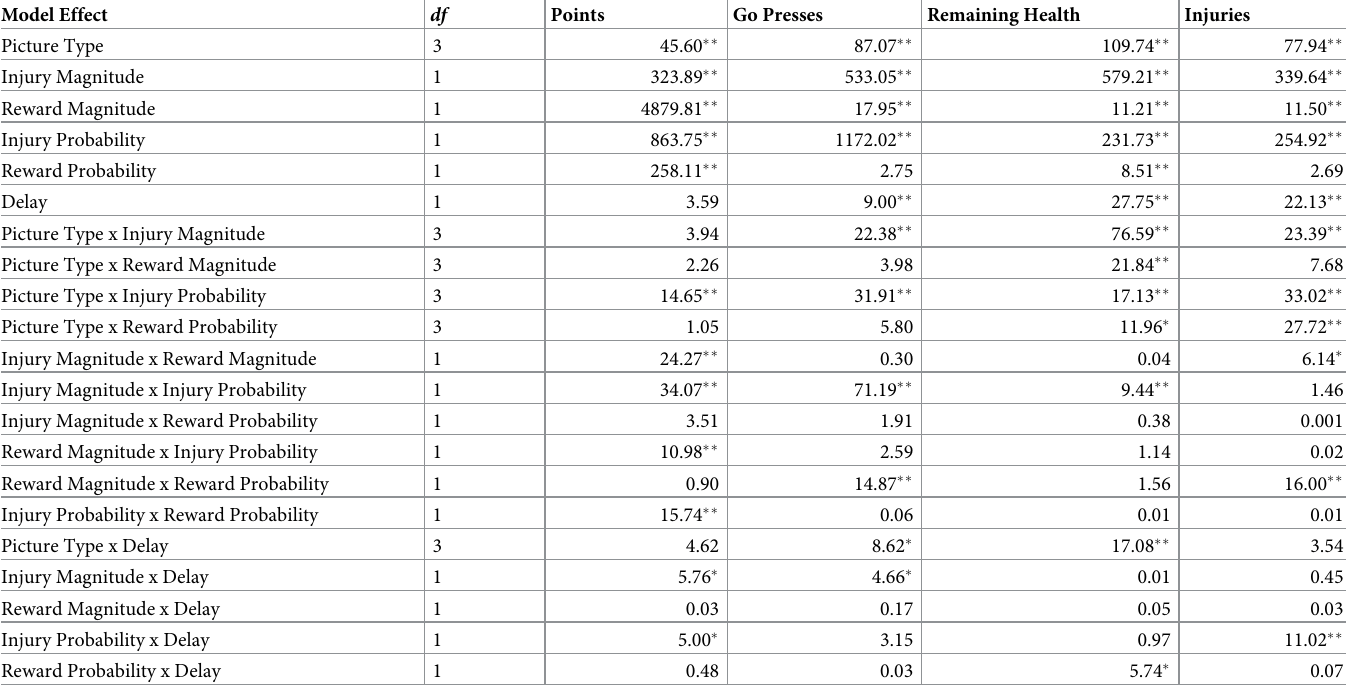
Table 2. Summary of generalized estimating equation model effects (Wald χ 2 ) for Points, Go Presses, Injuries, and